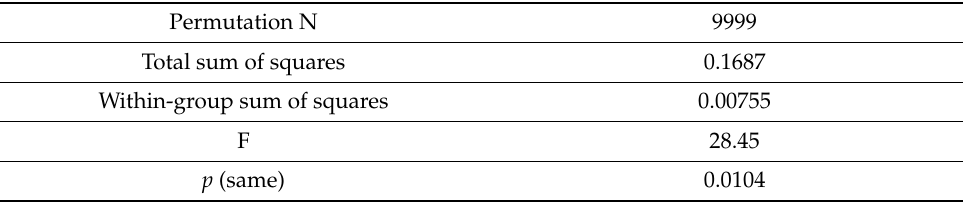
Table 3. One-way PERMANOVA test performed on whole-EO composition (using Bray-Curtis as the similarity index).